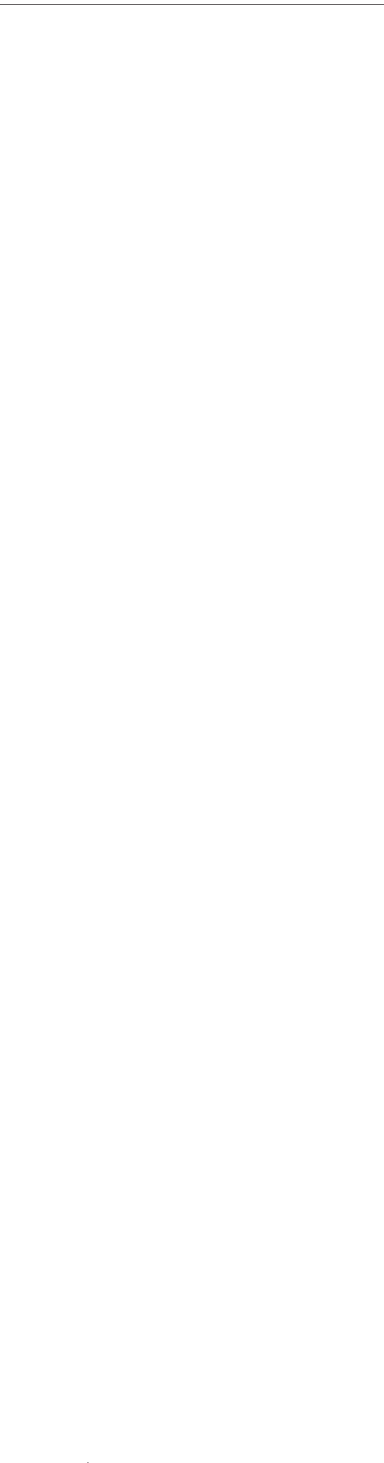
FIGURE 8 | PRP6-HO7 displays immunomodulatory activity in differentiating Mo-DCs and Mo-macrophages from active autoimmune SLE patients. Human Mo-DCs from active SLE patients (cohort 1) were incubated throughout their differentiation process with C4BP( b +) and C4BP( b -) (both at 12 nM), and with PRP6-HO7 at 32 nM. DC maturation was achieved by LPS (A) or gardiquimod (Gdq) (B) treatment. Cells were then collected, washed, and analyzed by fl ow cytometry for cell surface expression of the activation marker CD83, the co-stimulatory molecules CD86, CD80 and CD40, and HLA-DR. MFI, median fl uorescence intensity for the different surface markers. The concentrations of IL-12p70, and TNF- a were analyzed in the respective cell supernatants by ELISA. The results shown are the mean ± SD from 10 (LPS) or 11 (Gdq) independent donors. iDC, untreated, immature DCs; mDC, untreated, LPS-matured DCs (*p < 0.05; **p < 0.01; ***p < 0.001; ****p < 0.0001 compared with